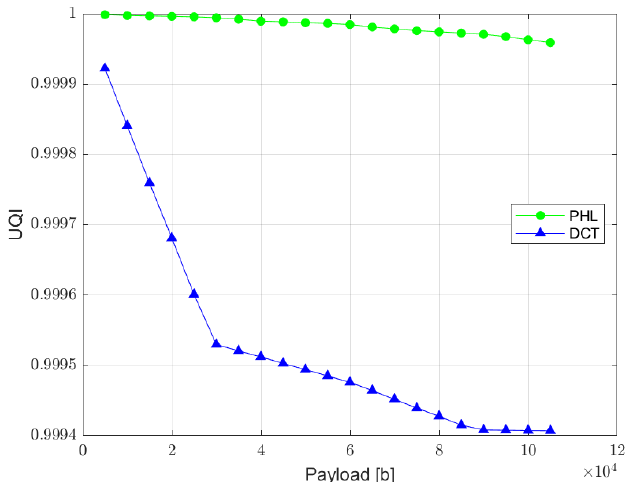
Figure 12. Relation between UQI index and the watermark capacity (PHL vs. DCT).